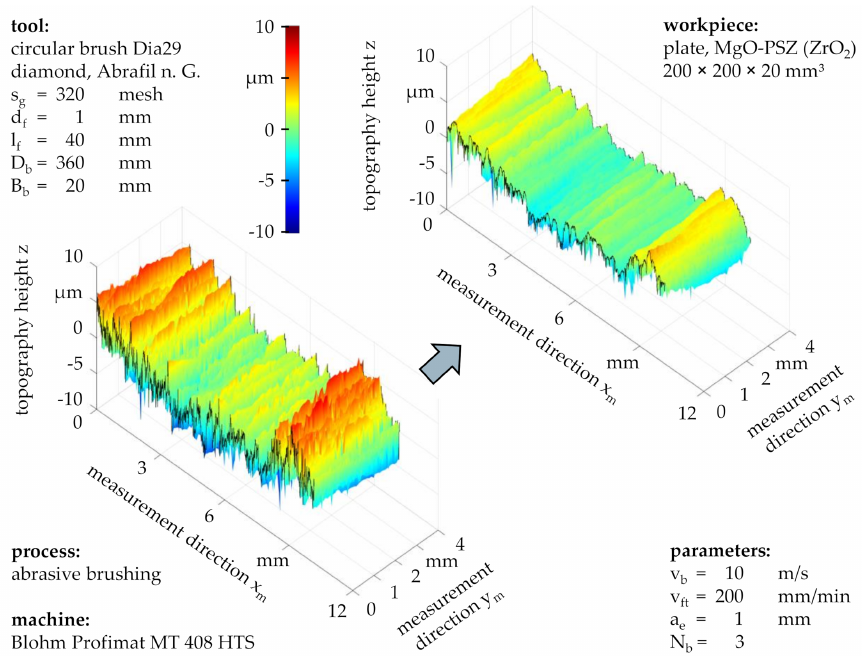
Figure 12. Topography of ZrO 2 , brushed with a brushing velocity of v b = 10 m /